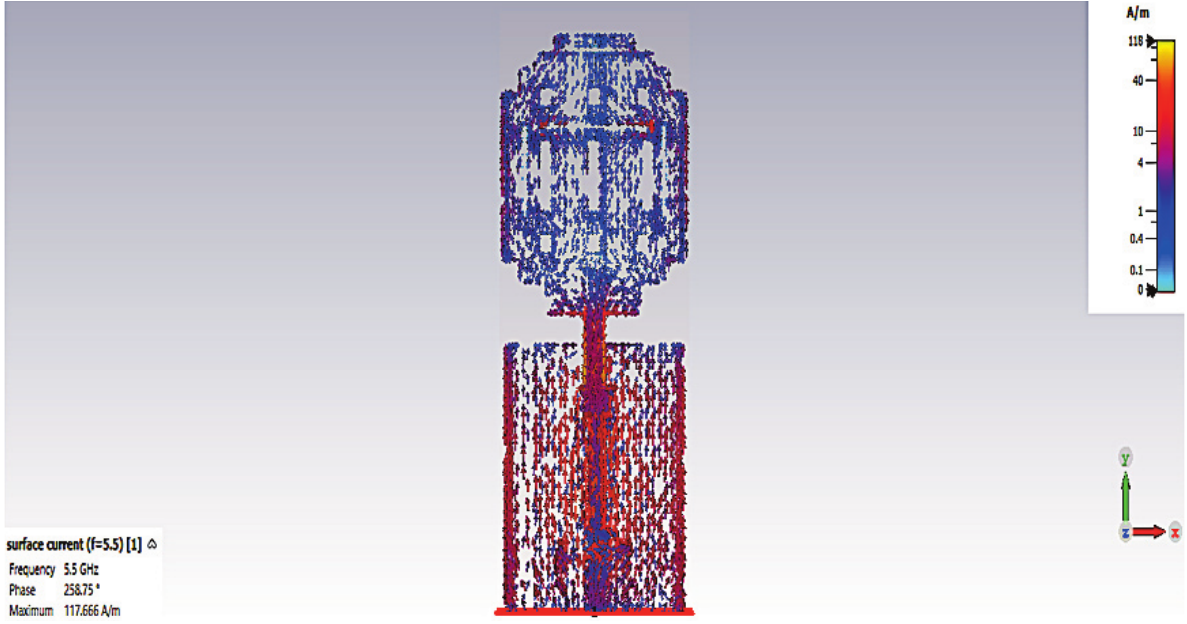
Fig. 7. Surface current intensity distribution for the simulated antenna at 5.5 GHz.